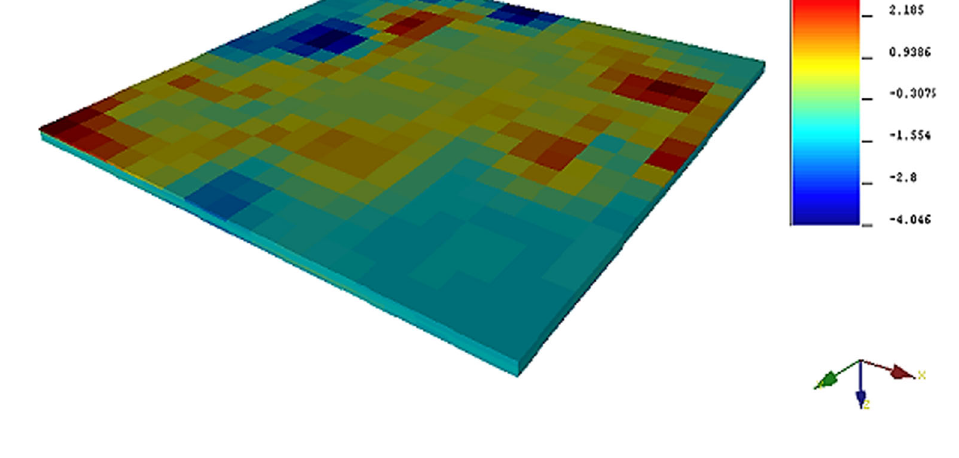
Fig. 6 Simulation map showing permeability distribution across the reservoir X model